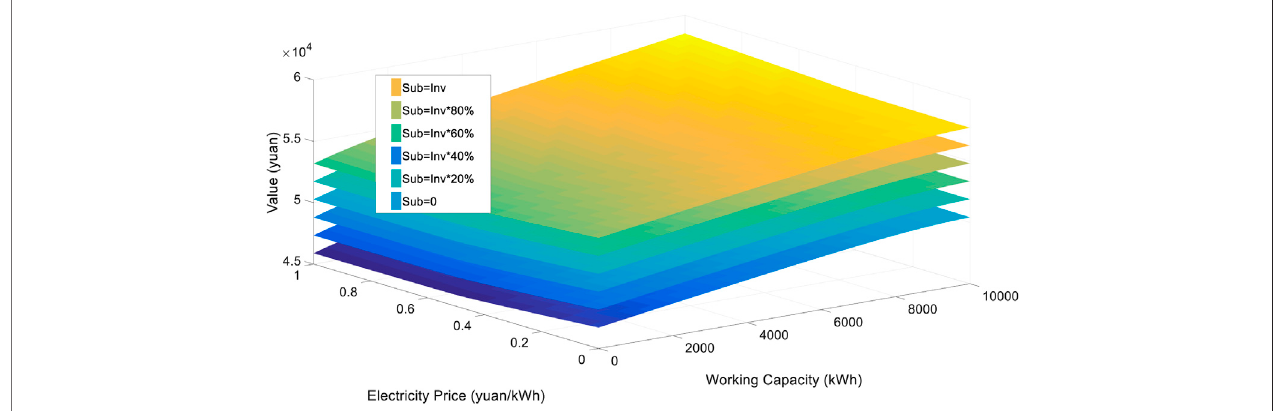
FIGURE 8 | The impact of the subsidy changes on value